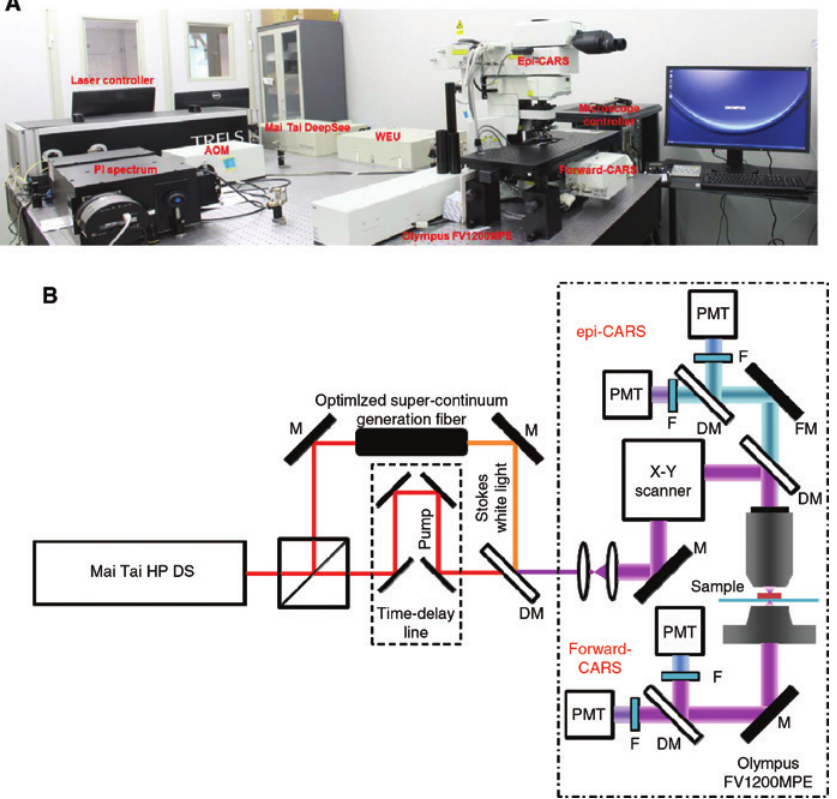
Figure 1: Home-made instrument of nonlinear optical microscopy. (A) The experiment setup. (B) Schematic